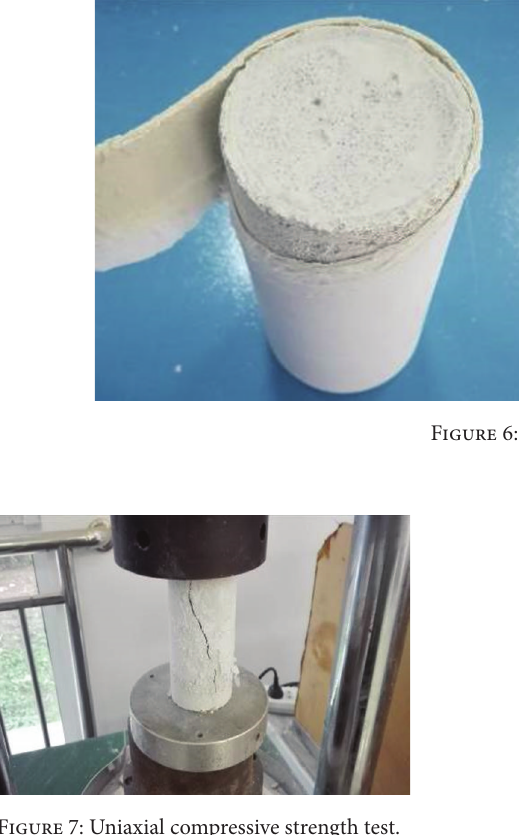
Figure 7: Uniaxial compressive strength test.